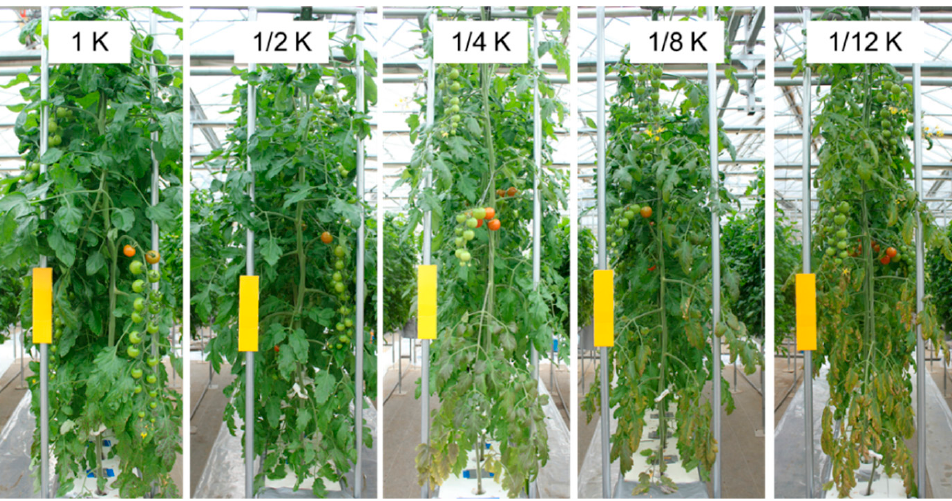
Figure 3. Outlooks of hydroponically grown cherry-type tomato ‘Carol 10’ under five K-supply regimes just before starting the fruit harvest.